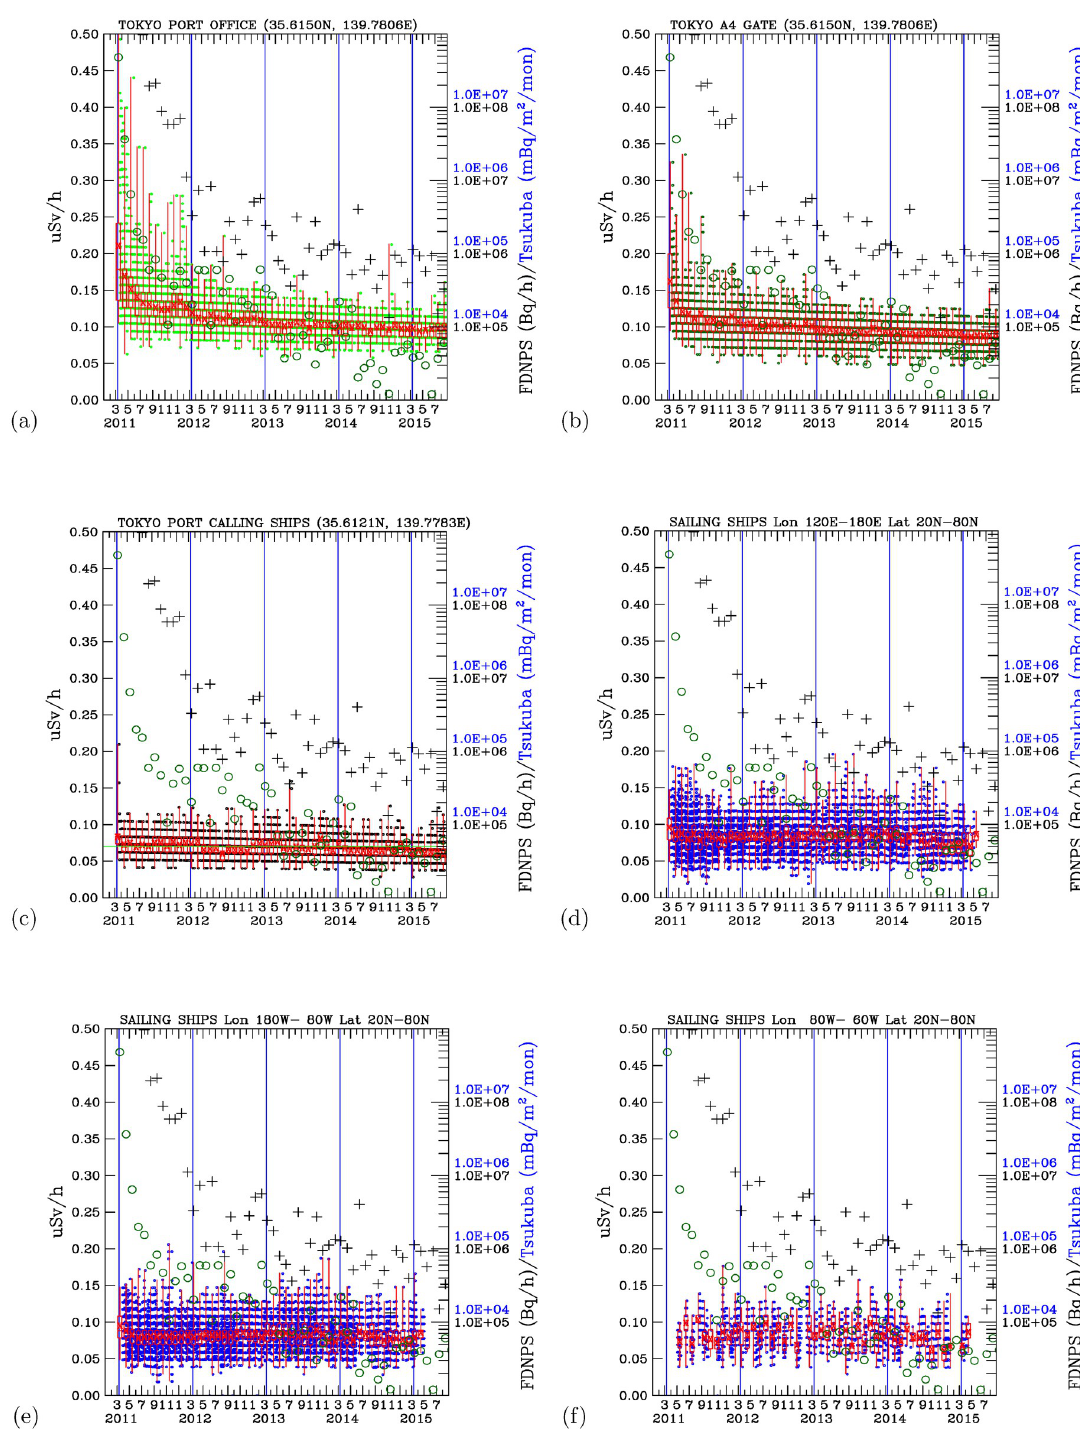
Fig 5. Time-series radioactivity dose rates, FDNPS emission fluxes (black crosses), and Tsukuba deposition fluxes (open circles). Measurements over the land surface sites at the (a) Port of Tokyo office and (b)Port of Tokyo gate A4. Measurements of (c) Port of Tokyo calling ships and sailing ships over (d) the western North Pacific; (e) the eastern North Pacific; and (f) the western North Atlantic. Green dots indicate all measurements over Tokyo, while blue dots indicate all measurements on ships. The red box indicates the 25 th , 50 th , and 75 th percentiles of all data in a month. The vertical red line indicates the maximum and minimum air dose rates (from all directions) measured in a month. The vertical blue lines indicate 11 March in 2011, 2012, 2013, 2014, and 2015.